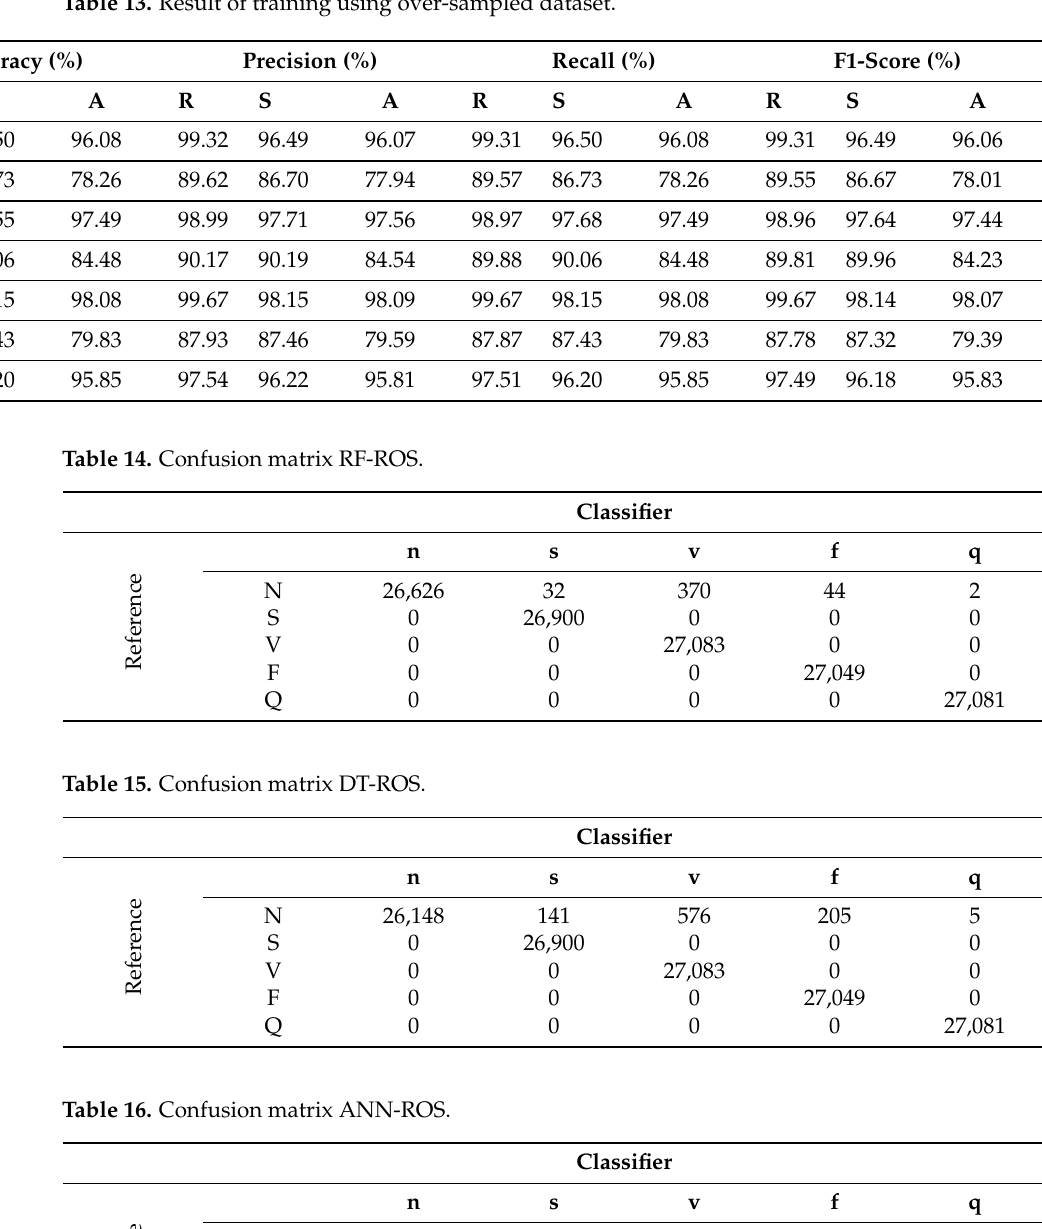
Table 13. Result of training using over-sampled dataset.